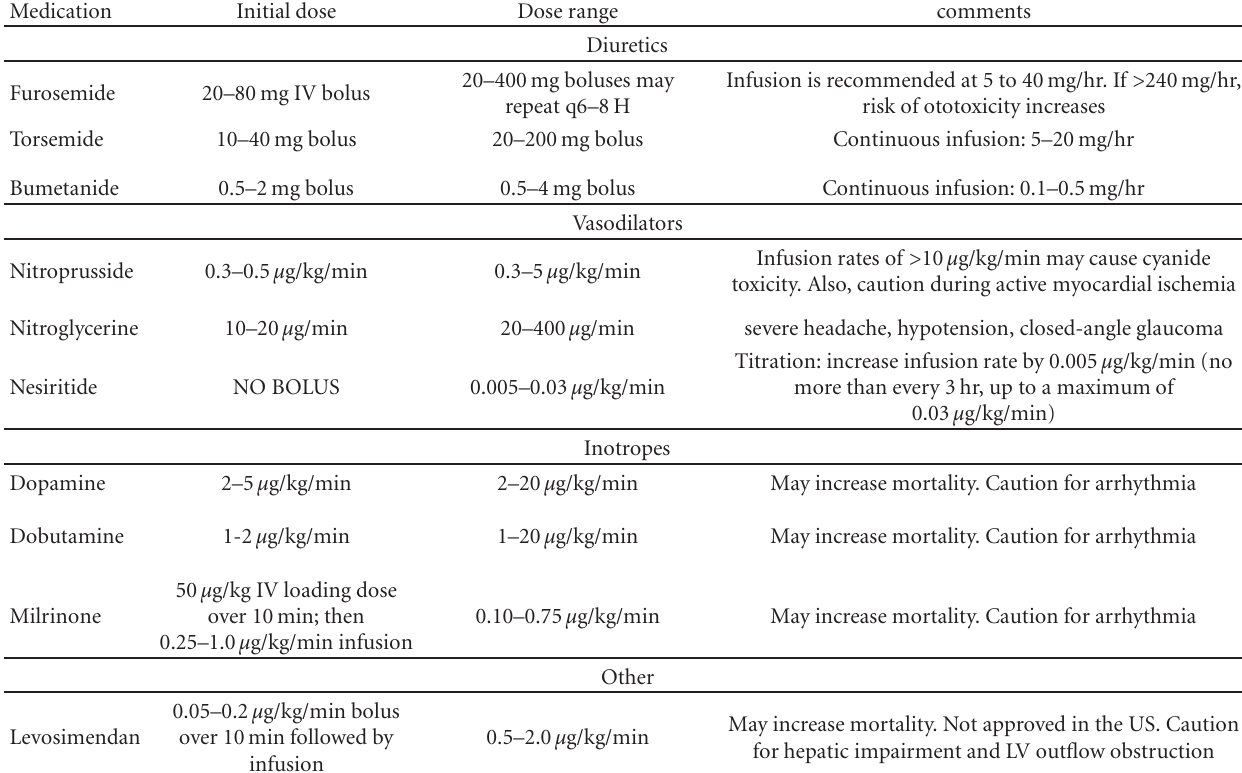
Table 1: Pharmacologic agents in the management of patients with